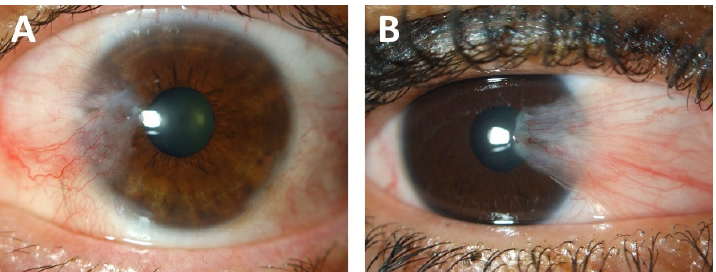
Figure 1. Clinical representation of grade III ( A ) and grade IV ( B ) pterygium. Ocular surface photographs were taken at the Antwerp University Hospital and graded according to the Johnston, Williams, and Sheppard classification system [7] .